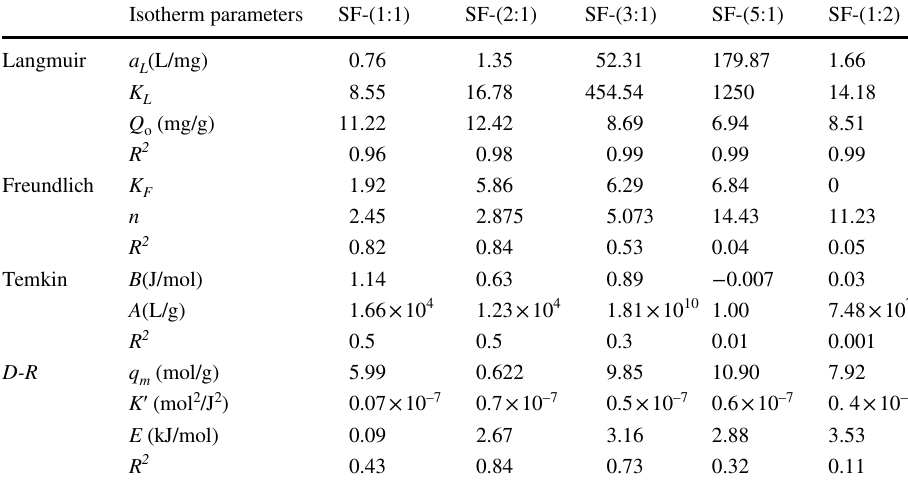
Table 1 Isotherm Parameters for R K-HL dye Adsorption on